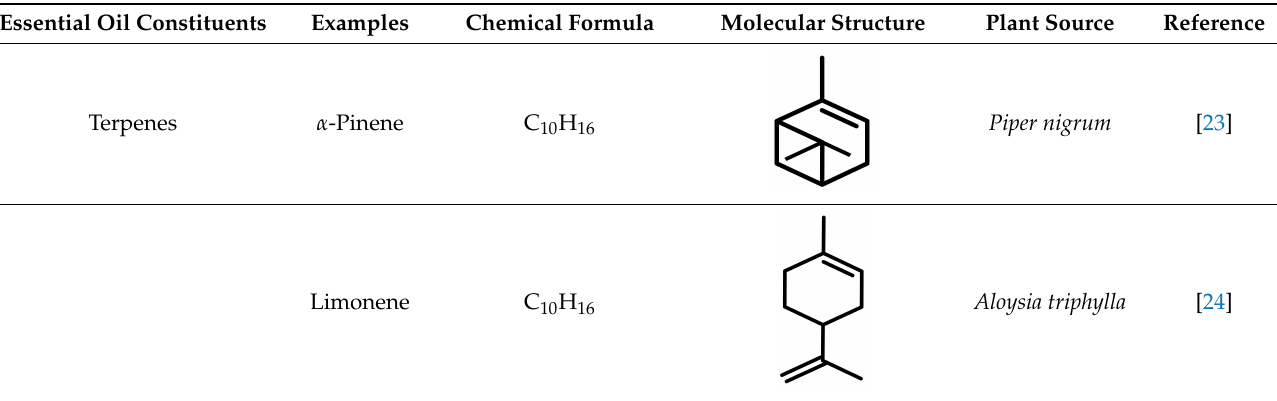
Figure 1. Chemical structural formulas of some major constituents of essential oils. Table 1. Major active chemical constituents of some important essential oils with molecular structure and plant